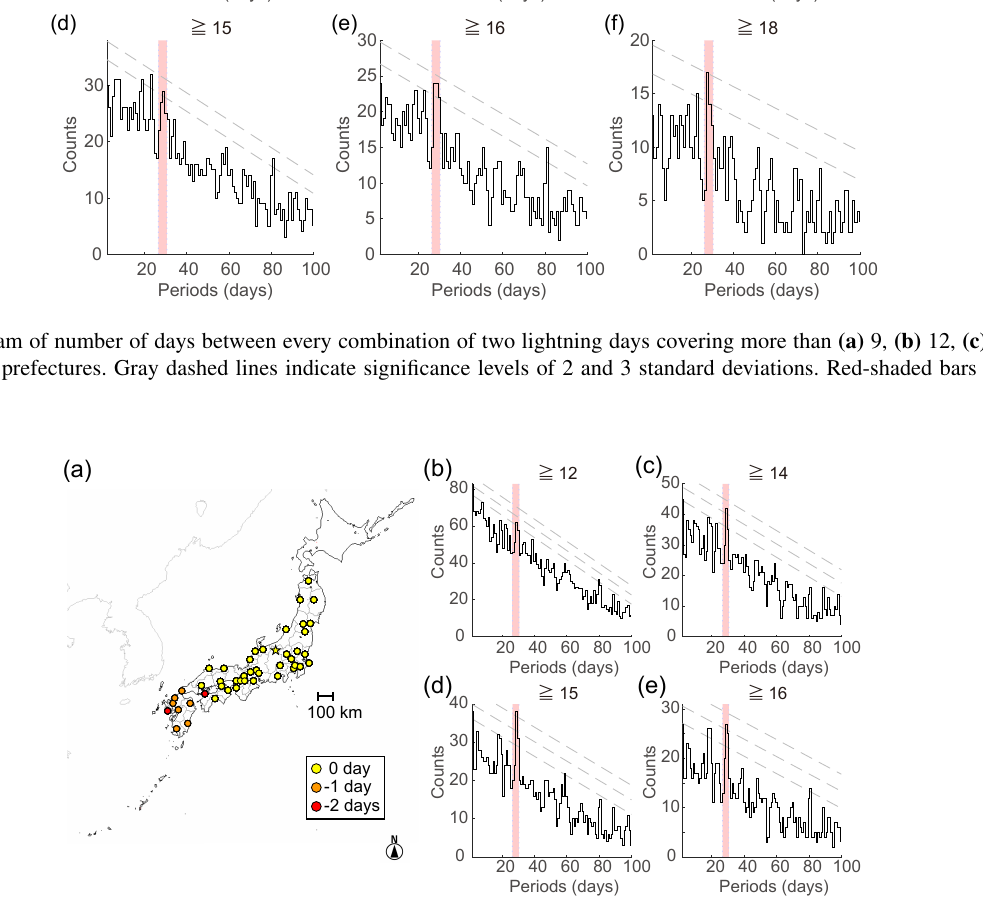
Figure 3. (a) Time lag of the 27-day component in lightning activity in each prefecture compared to that of Nagano Prefecture (indicated by a star) in central Japan. Panels (b–e) are the same as Fig. 2, except for considering the 1-day time lag between the area of Ky ¯ ush ¯ u and its vicinity (orange and red circles in a ) and the rest of Japan (yellow circle in e ). The gray dashed lines correspond to 2, 3, and 4 standard deviations. The red bars indicate the 27–30-day